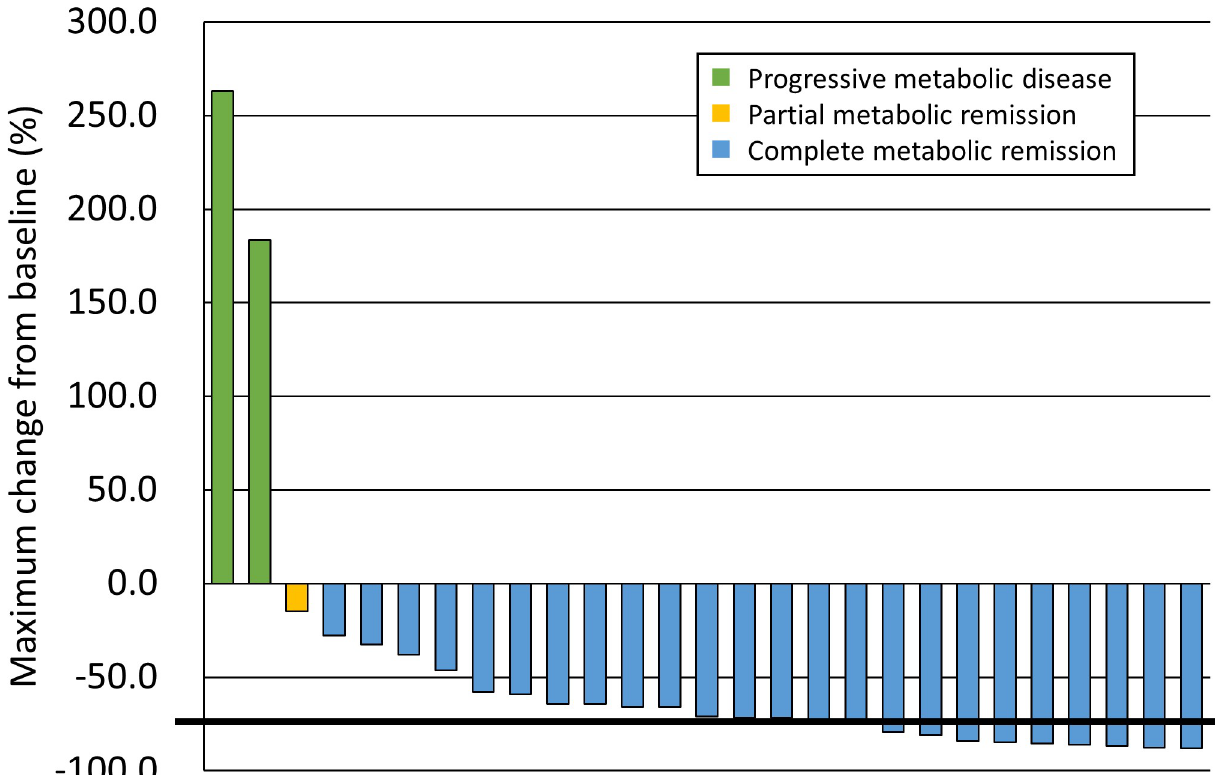
Fig 1. Waterfall plot of the maximum change in SUVmax. SUVmax, maximum standardized uptake value.